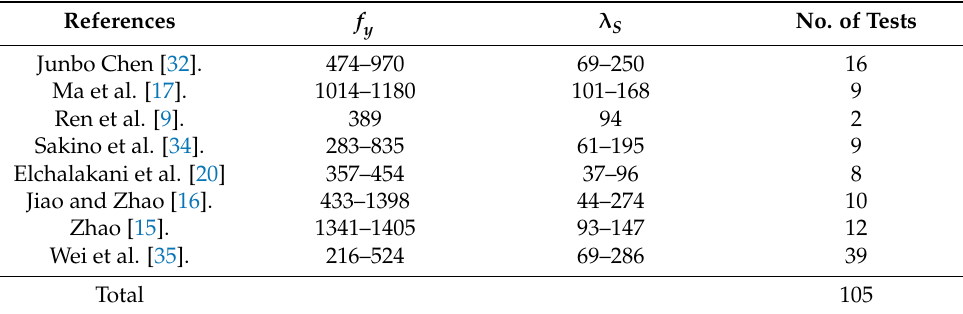
Table 4. Statistics of previous experimental test data for 105 CHS stub